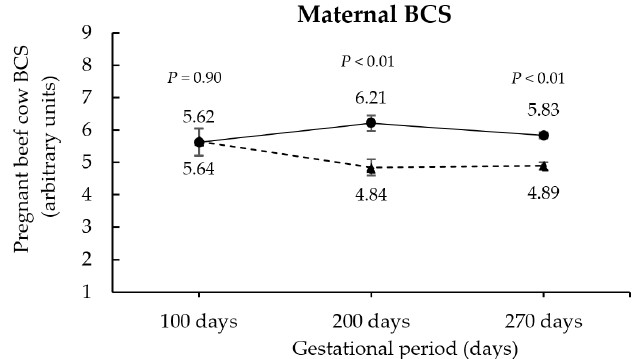
Figure 2. Effects of maternal protein supplementation status on pregnant beef cow body condition score. RES (unsupplemented cows at mid-gestation, n = 24); CON (cows supplemented with protein at mid-gestation, n = 19). The symbols represent the average data from CON (●) and RES ( ▲ ) groups. 3.2. Offspring Performance The 120- and 210-day-old CON calves were 12 kg and 17 kg heavier than RES calves ( p ≤ 0.04), respectively. The average BW at 120 days of age was 126 and 138 kg for RES and CON, and that at 210 days of age was 197 and 214 kg for RES and CON, respectively. In the backgrounding, RES males were ~22 kg lighter than CON males (RES: 255 and CON: 277 kg, p < 0.001). Within the female group, RES progenies were ~16 kg lighter than CON